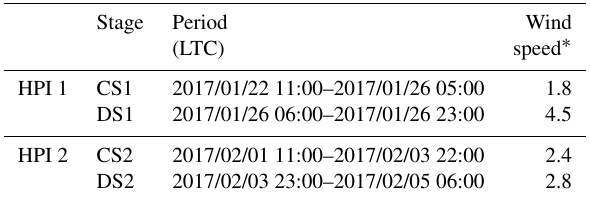
Table 4. Stages of HPI along with the horizontal surface wind speed during the different pollution stages.